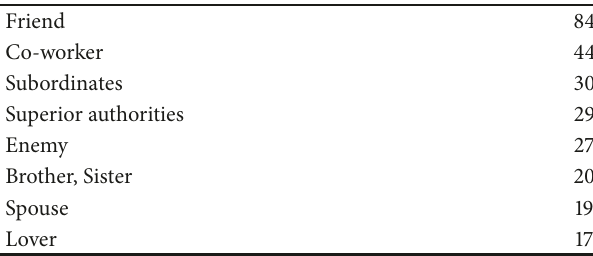
Table 2: Number of relationship attributes for the data